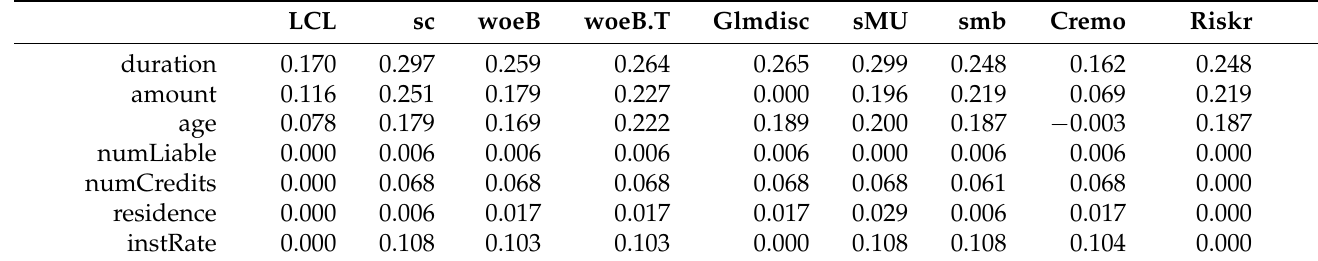
Table 2. Gini coefficient of WoE transformed variables on validation